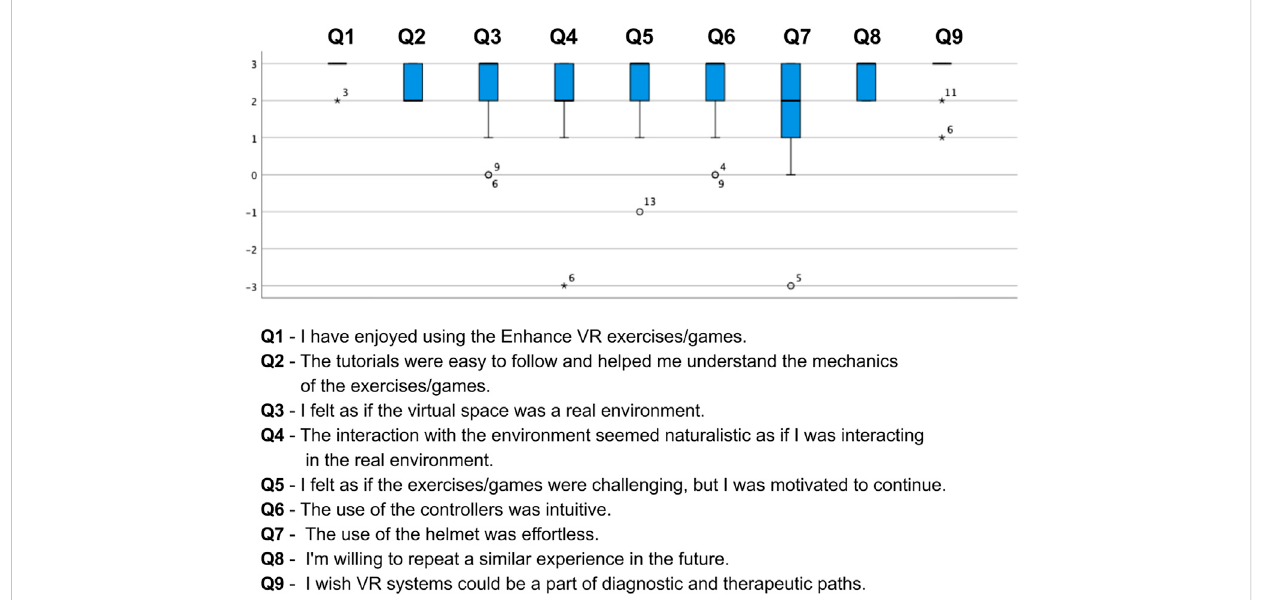
FIGURE 4 Boxplot showing the responses to the satisfaction questionnaires. After the intervention, the participants replied to 9-item satisfaction questionnaires on using and enjoying the Enhance VR games. They responded on a 7-point Likert scale, where -3 means ’ completely disagree ’ with the statement and 3 means ’ completely agree ’ with the statement. The graph shows the distribution of the responses for each statement, thebox represents the interquartile range (IQR) and the central line represents the median value. The whiskers indicate all of the valuesthat are not outliers. The circles and asterisks represent the outliers depending on their standard deviation to the mean with the number of